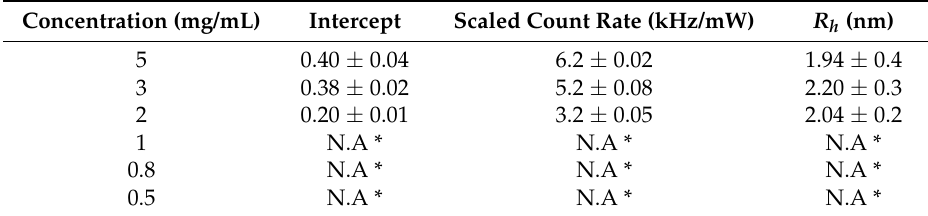
Table 1. Intercept, scaled count rate and hydrodynamic radius ( R h ) of lysozyme at different concentrations obtained with the 45 mW laser